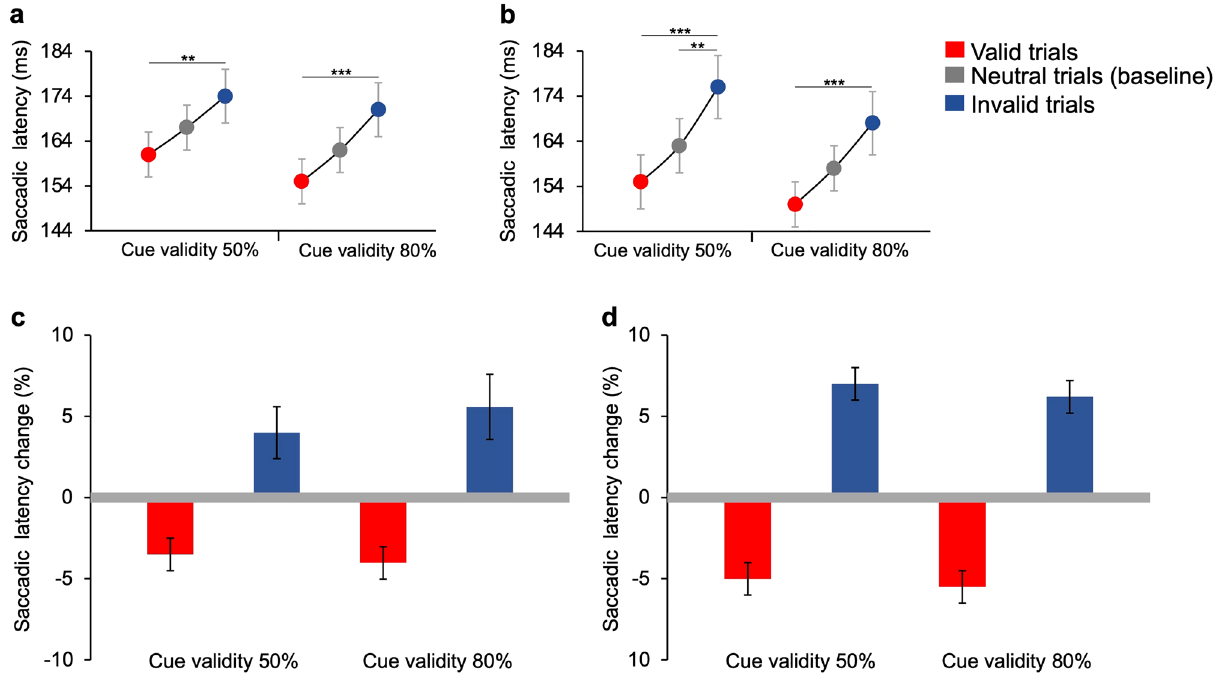
Figure 4. Saccadic latencies in neutral, valid, and invalid trials. (a) Experimental condition. Group average latencies in neutral (grey), valid (red), and invalid (blue) trials. Post-hoc t- t ests (Bonferroni correction) show a significant difference between valid versus invalid trials for 50% ( t (2) = 3.99, p = 0.008) and 80% cue validity ( t (2) = 5.21, p < 0.001). (b) Control condition. Group average latencies in neutral (grey), valid (red), and invalid (blue) trials. Post-hoc t -tests (Bonferroni correction) show significant differences between valid versus invalid trials ( t (2) = 6.72, p < 0.001), and invalid versus neutral trials (shown with line near the baseline; t (2) = − 4.05, p = 0.007) for 50% cue validity. They also show a significant difference between valid versus invalid trials ( t (2) = 6.16, p < 0.001) for 80% cue validity. Asterisks mark statistically significant pairwise comparisons across trial types: ** p < 0.01, *** p < 0.001. Error bars are SEM. (c) Experimental condition. Group average latencies changes in valid (red) and invalid (blue) trials compared to the baseline (grey line, neutral trials with two non- optimal features). (d) Control condition. Group average latencies changes in valid and invalid trials compared to the baseline (neutral trials with two identical low-luminance grey